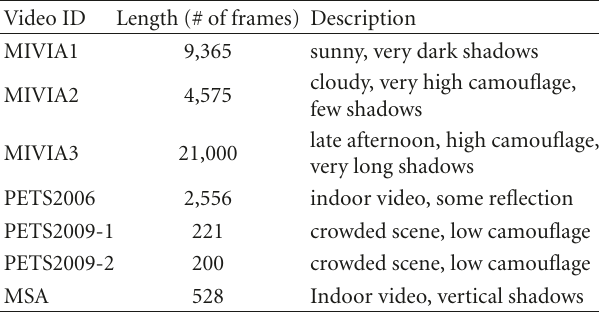
Table 2: Performance obtained by the algorithms on the databases. In bold the best precision, recall, and f -score for any